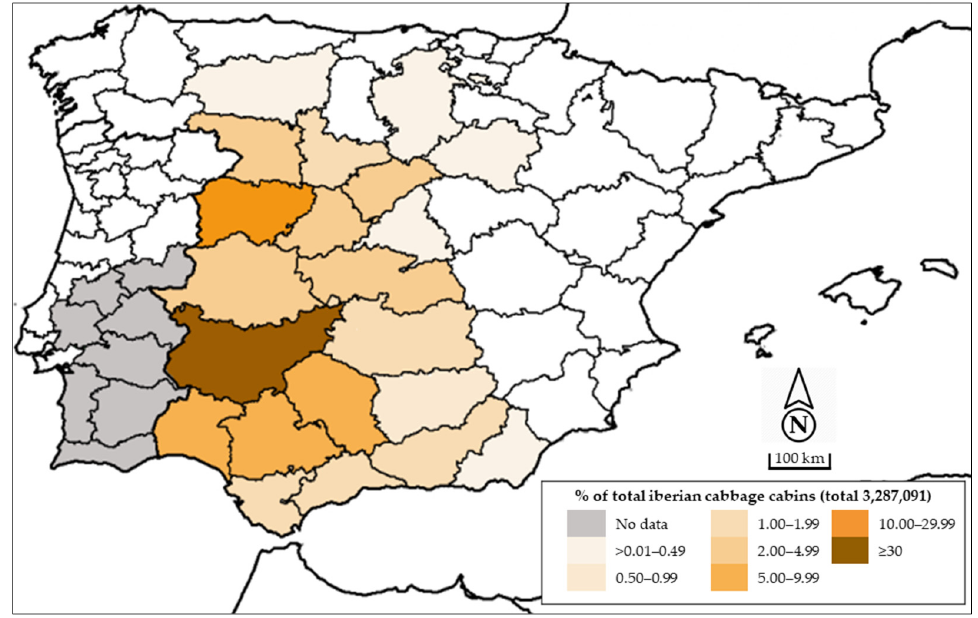
Figure 2. Distribution of Iberian Pig in the Iberian Peninsula (2018). Source: [57]. Authors own elaboration.